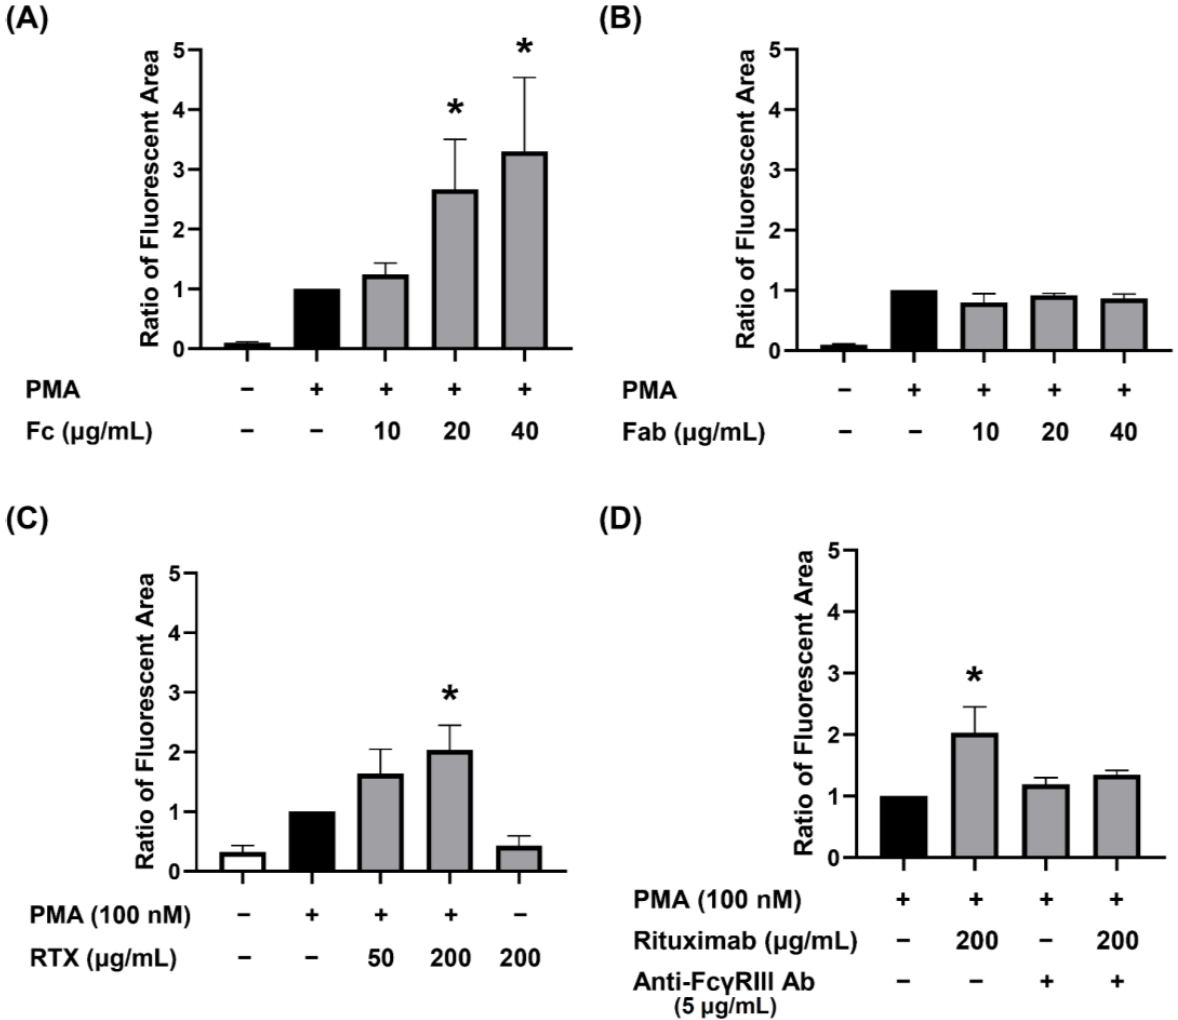
Figure 4. Dose-dependent augmenting effect of Fc, but not Fab, fragment derived from human IgG and IgG1 (rituximab, a human chimeric monoclonal IgG1 antibody) on PMA-stimulated dHL-60 NET formation via Fc γ RIII engagement. The NET area was detected by SYTOX green nucleic acid stain and was denoted by the ratio compared to PMA stimulation only. ( A ) Dose-dependent augmentation (10–40 µ g/mL) of human IgG Fc fragment engagement on PMA-stimulated dHL-60 NET formation. ( B ) Negligible augmenting effect of human IgG Fab fragment from 10–40 µ g/mL on PMA-stimulated dHL-60 NET formation. ( C ) Dose-dependent augmentation of rituximab (RTX, an IgG1 monoclonal antibody, 50–200 µ g/mL) on PMA-stimulated dHL-60 NET formation. ( D ) The anti-Fc γ RIII antibody (5 µ g/mL) pretreatment can suppress the RTX-augmented PMA-stimulated dHL-60 NET formation. * p < 0.05 compared to PMA only.